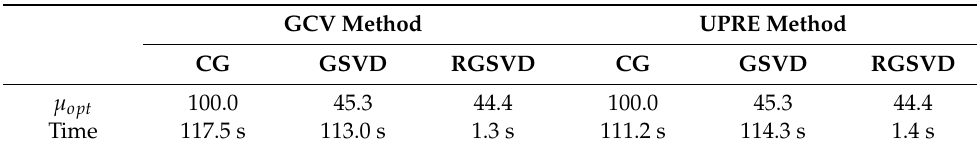
Table 1. The optimal regularization parameters and the elapsed times for different regularization